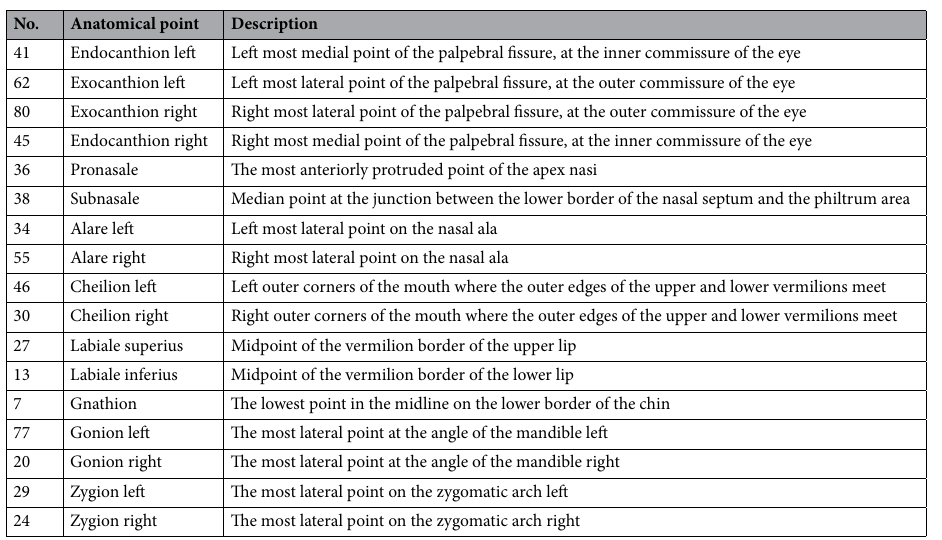
Table 1. Anchor anatomical points and